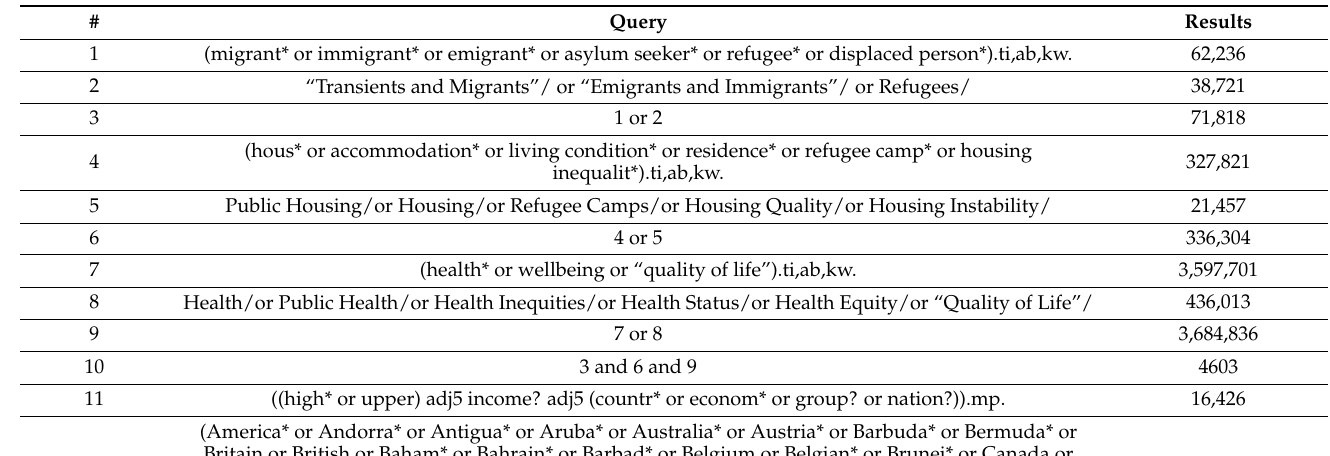
Table 2. Preliminary search strategy for MEDLINE (OVID) (6 November